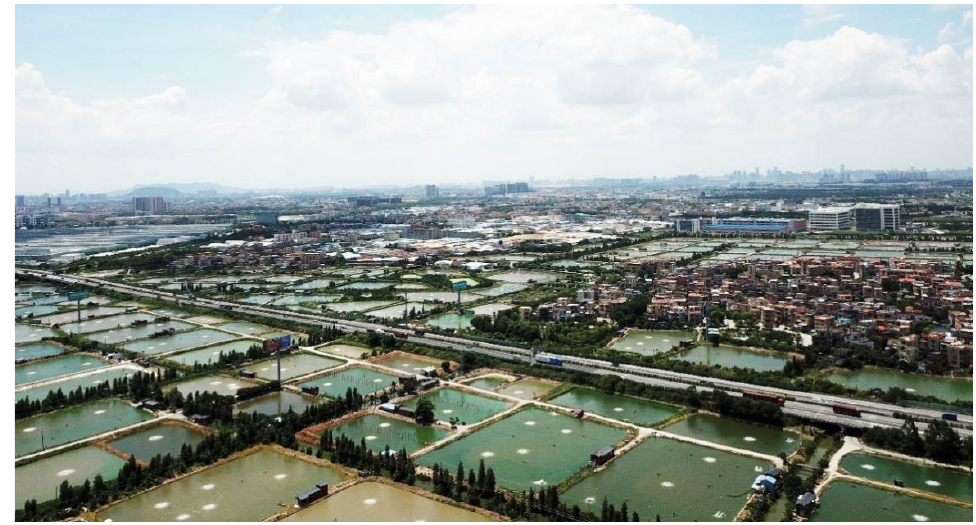
Figure 1. An example of ponds in the Pearl River Delta (PRD) region, China: ponds of Leliu, Shunde District, Foshan City (photo taken using a drone in 16 July 2021: courtesy of Long Yang).